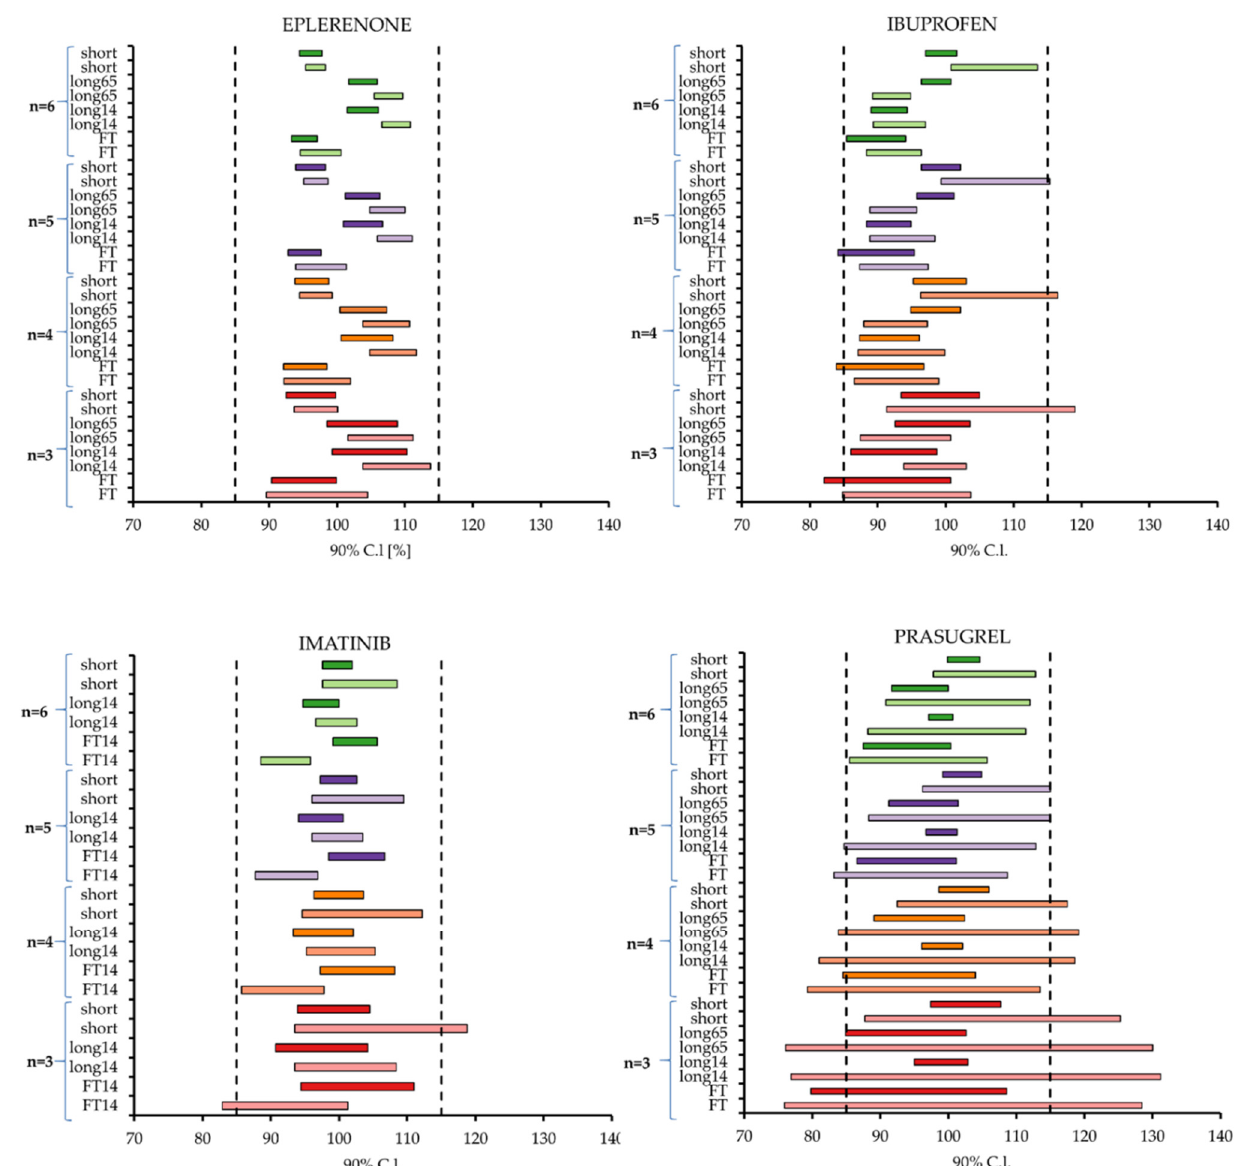
Figure A1. Retrospective study: 90% confidence intervals (90% C.I) for the stability of five drugs using n = 3, 4, 5, and 6. Abbreviations: Short—short-term stability, FT—freeze and thaw stability, long—long-term stability. Numbers 14 and 65 indicate the storage temperature of − 14 °C and − 65 °C, respectively. Low QC—light color, high QC—intensive color.